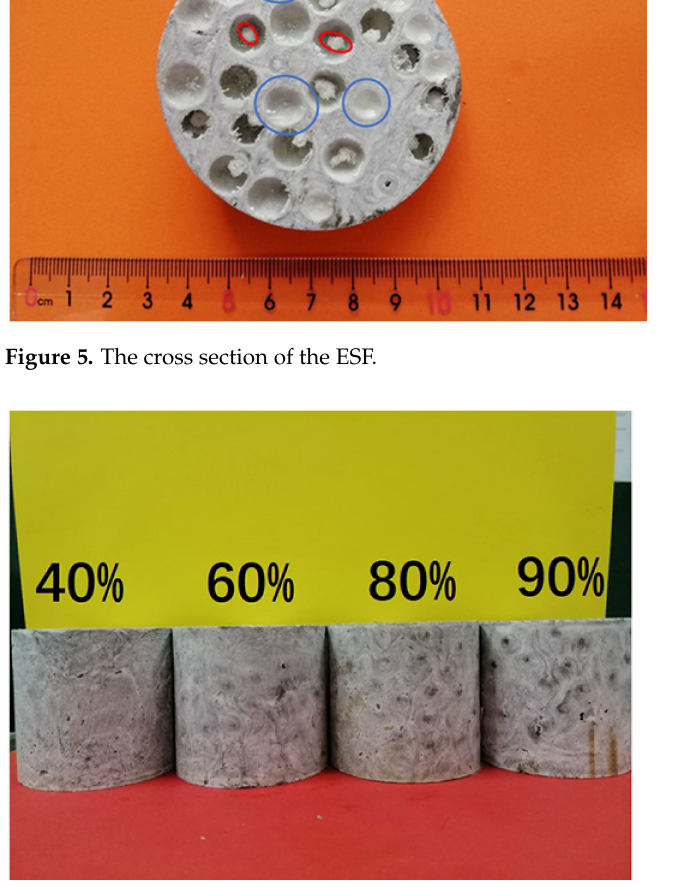
Figure 6. ESF filled with AR-HEMS with a different stacking volume fraction.